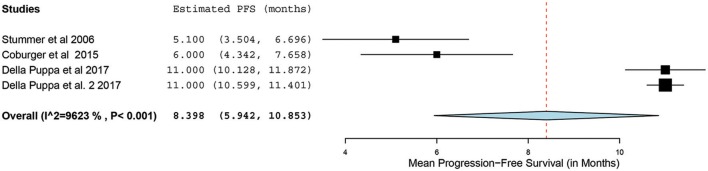
Forest plot graph representing the meta-analysis of mean progression-free survival (95% confidence interval [CI]) among patients with primary high-grade glioma treated using 5-aminolevulinic acid–guided surgical resection. Used with permission from Barrow Neurological Institute, Phoenix, Arizona.